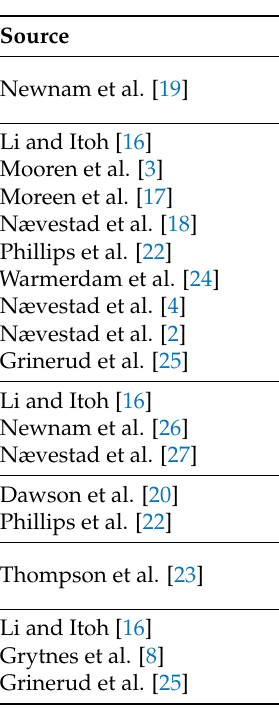
Table 3. Organizational